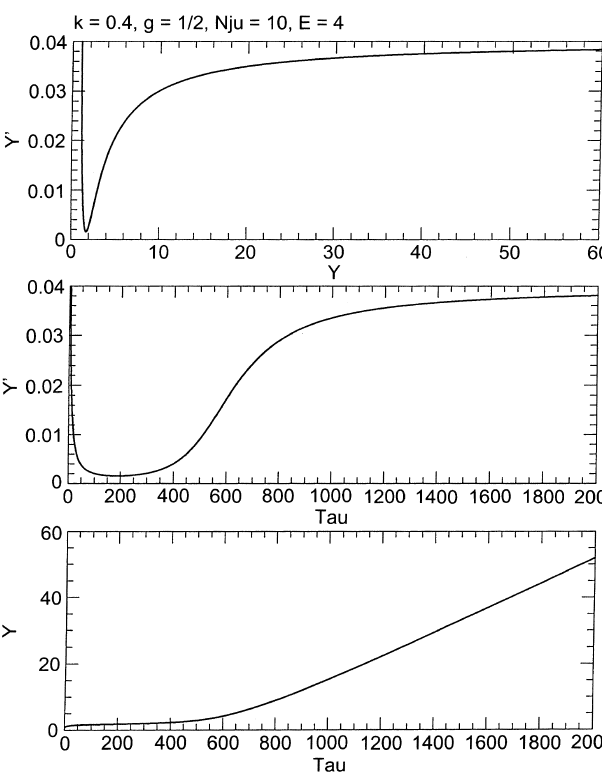
Fig. 13. A super-critical (cid:133) (cid:106) > (cid:106) crit (cid:134) ; heavily damped (cid:133) (cid:109) (cid:3) (cid:136) 10 (cid:134) magnetic flux rope seen evolving to the asymptotic limit. The format is the same as in Fig.